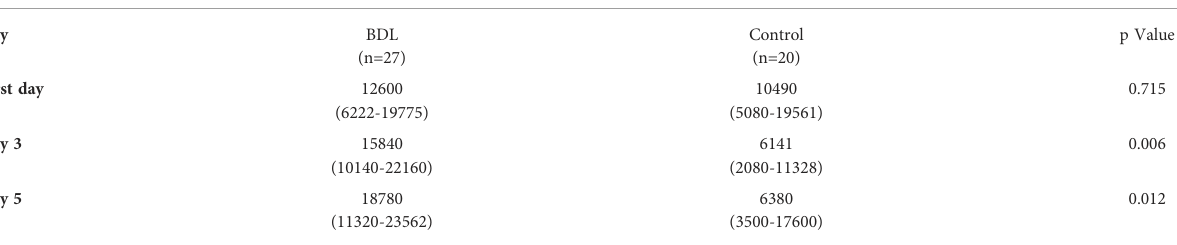
aMT6s Excretion in Urine (ng/12h)